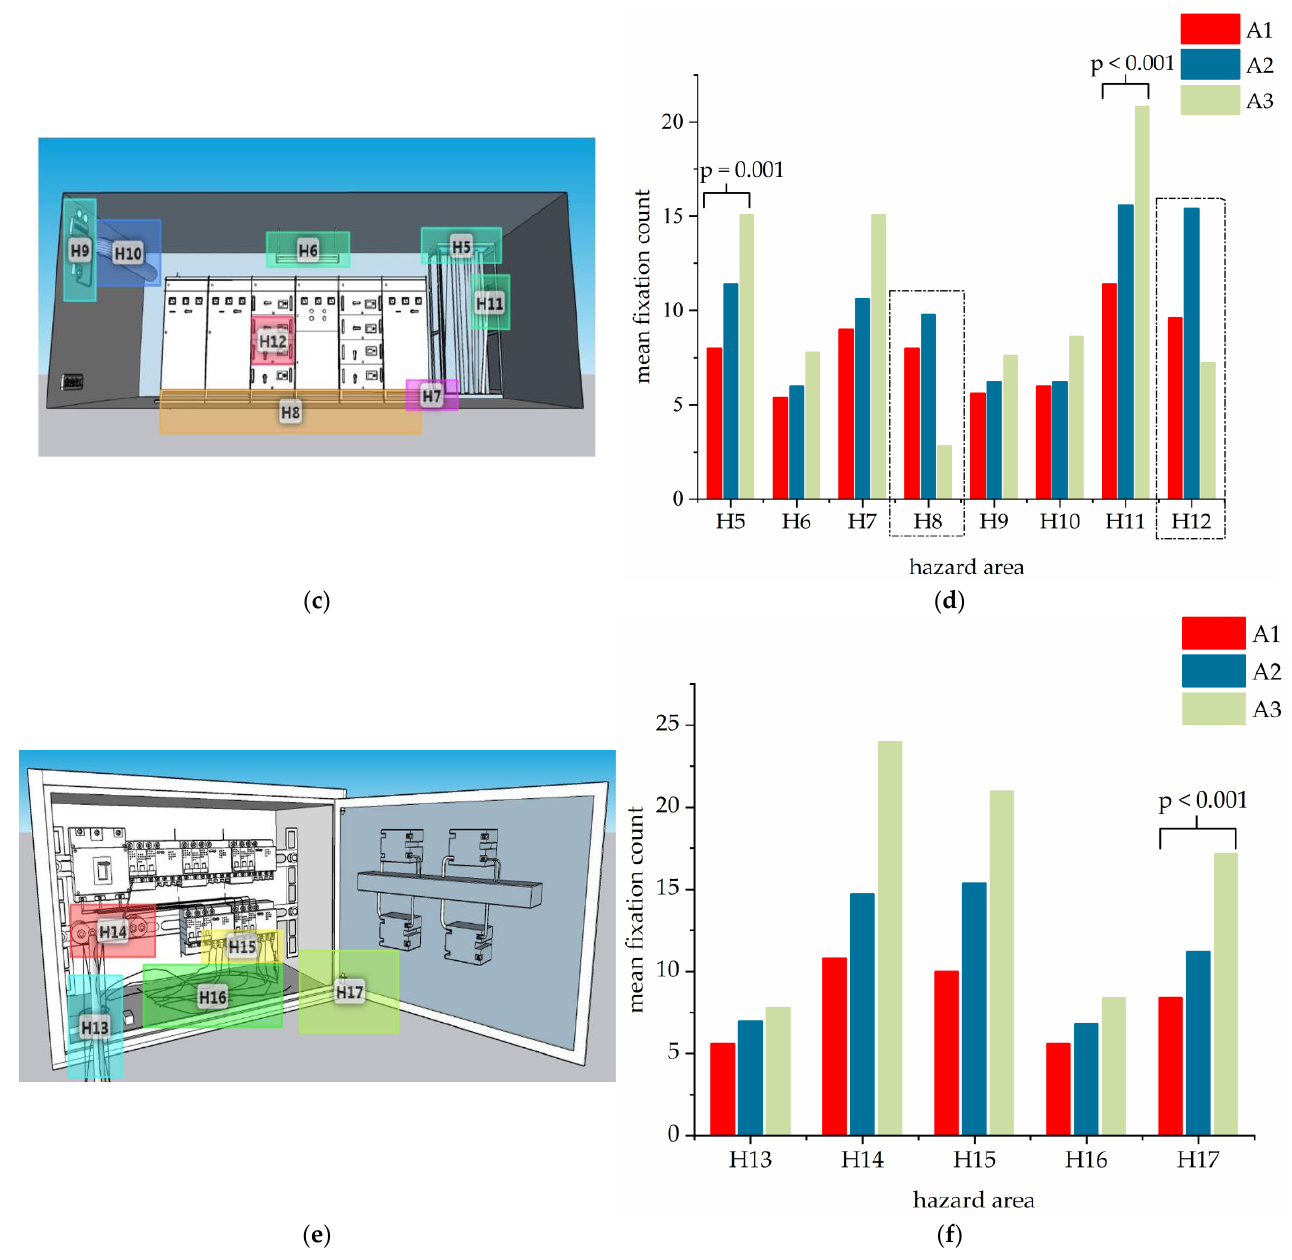
Figure 9. Statistical graph of hazard distribution and mean fixation count in the test images. ( a ) AOI division in test image 1, ( b ) fixation count in test image 1, ( c ) AOI division in test image 2, ( d ) fixation count in test image 2, ( e ) AOI division in test image 3, ( f ) fixation count in test image 3. Boxes in Figure 9d represent abnormal data. Except for the two hazard areas, H8 and H12, in test image 2, the A3 group had higher attention than the workers in the A1 and A2 groups on the remaining hazard area. Table 7. The mean fixation count of three groups at each hazard area.